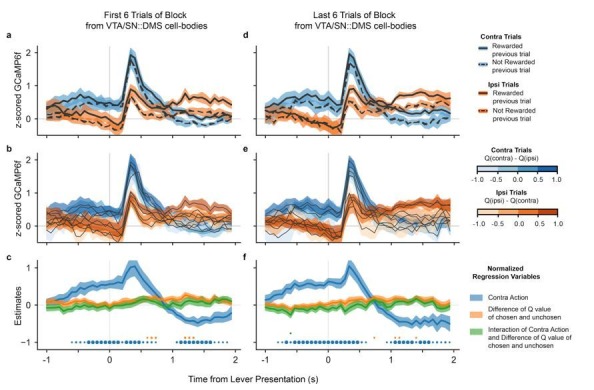
Early and late trials in block are both modulated by chosen value and contralateral action (VTA/SN::DMS Cell-bodies, n = 7 sites)(A) GCaMP6f signal from VTA/SN::DMS Cell-bodies (n = 7 sites) from first 6 trials of a block. Traces are time-locked to the lever presentation for contralateral trials (blue) and ipsilateral trials (orange), as well as rewarded (solid) and non-rewarded previous trial (dotted). Colored fringes represent 1 standard error from activity averaged across recording sites (n = 7). (B) GCaMP6f signal for contralateral trials (blue) and ipsilateral trials (orange), and further binned by the difference in Q values for chosen and unchosen action. Colored fringes represent 1 standard error from activity averaged across recording sites (n = 12). (C) Mixed effect model regression on each datapoint from 3 seconds of GCaMP6f traces. Explanatory variables include the action of the mice (blue), the difference in Q values for chosen vs. unchosen actions (orange), their interaction (green), and an intercept. Colored fringes represent 1 standard error from estimates. Dots at bottom mark timepoints when the corresponding effect is significantly different from zero at p<.05 (small dot), p<.01 (medium dot), p<.001 (large dot). P values were corrected with Benjamini Hochberg procedure. (D-F) Same as (A-E),except using trials from the last 6 trials of the block.